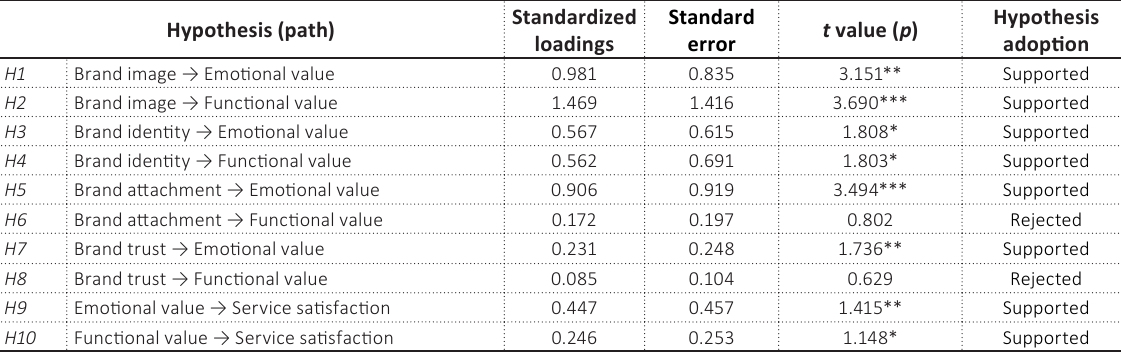
Table 4. Analysis results of a structural